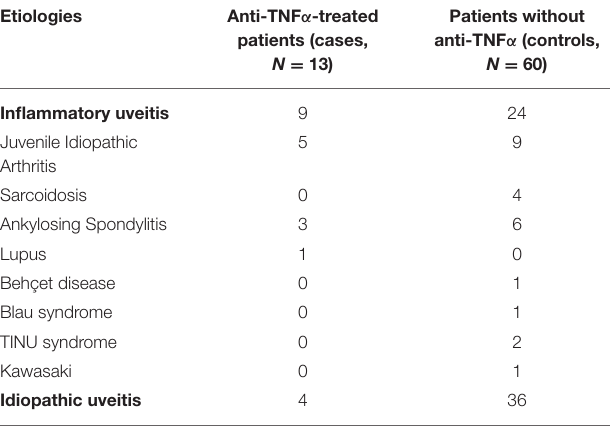
TABLE 2 | Etiologic data for the 13 anti-TNF α treated patients (cases) and the 60 no anti-TNF α patients (control). Etiologies Anti-TNF α -treated